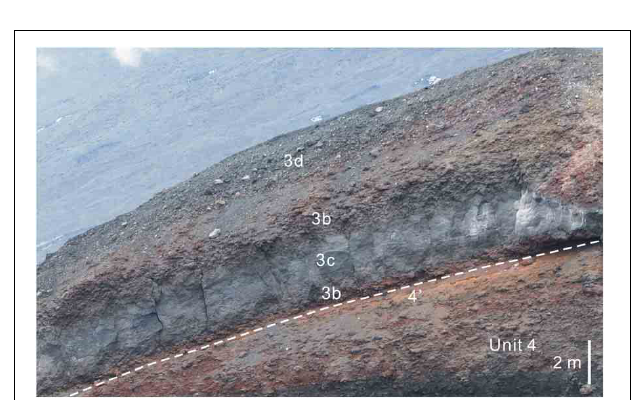
same as Figure 2 . The host rock of the feeder system is marked with red lines. Yellow lines show the unit boundaries. Blue lines are sub–boundaries inside the same unit. Boxes with dashed lines show the areas in Figures 4–6 and 8 .